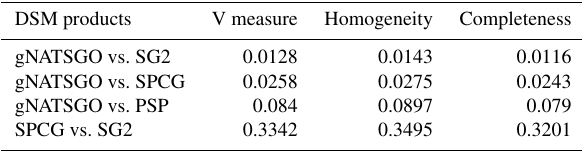
Figure 6. Pearson correlations between all products for pH at 0– 5cm. Strong correlations, especially between gNATSGO vs. PSP and SG2 vs. SPCG, are shown. Table 3. V-measure statistics for pH × 10 at 0–5cm.